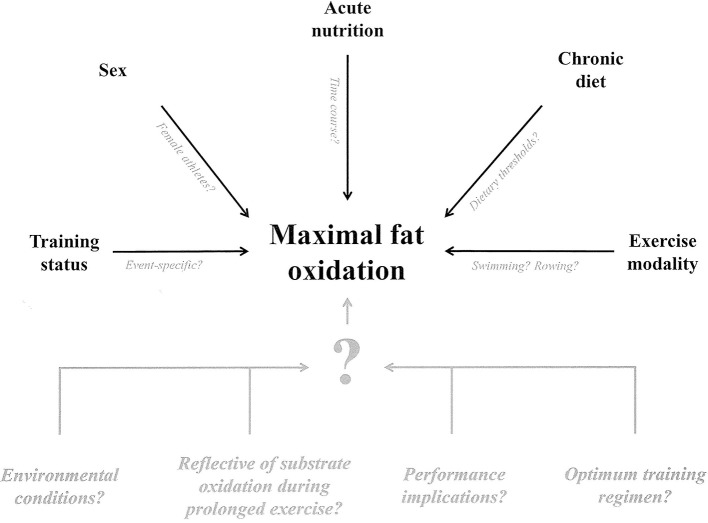
Schematic illustration of the identified determinants of maximal fat oxidation during graded protocols (black) and key identified unknown factors (gray).